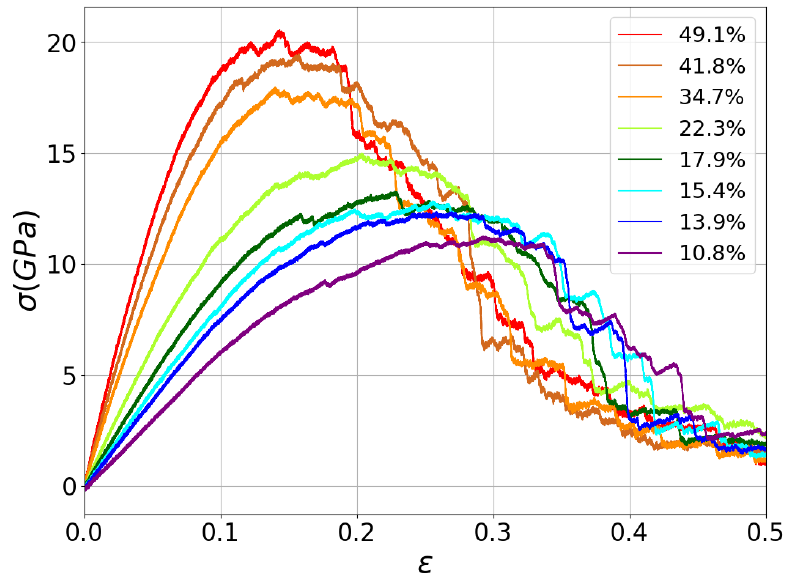
Figure 2. Stress–strain curve of the simulated nanofoams with different sp 3